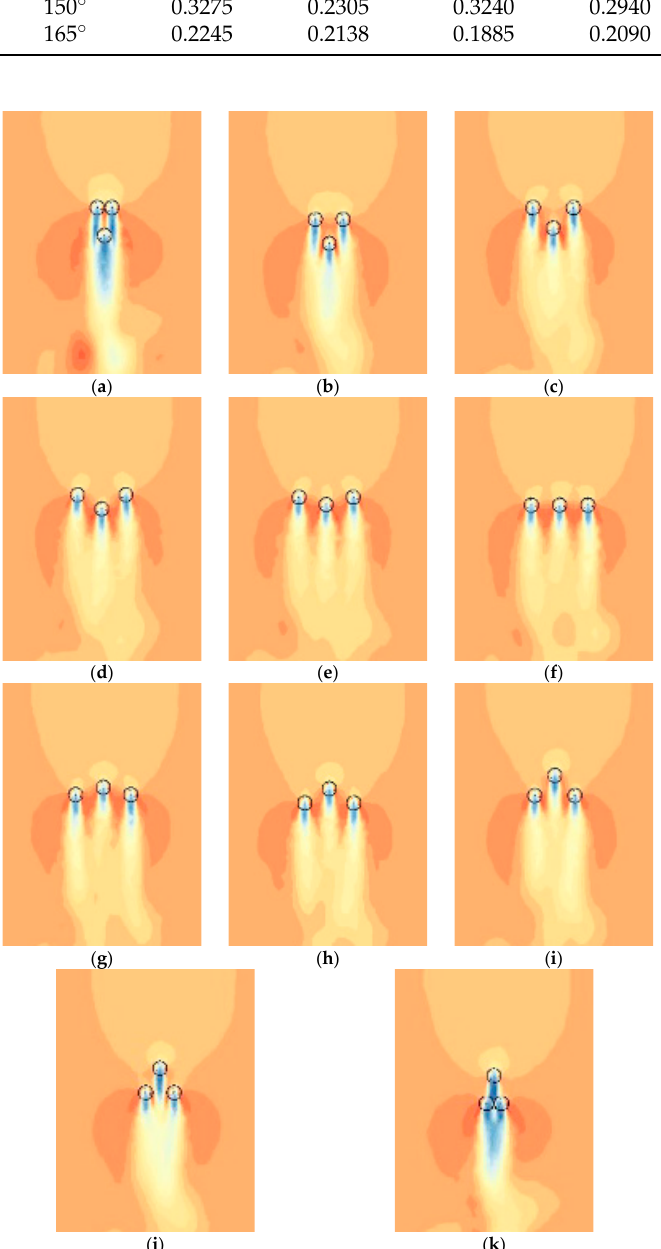
Figure 18. Contour plots of velocity magnitude within the domain for oblique angles of ( a ) 15°, ( b ) 30°, ( c ) 45°, ( d ) 60°, ( e ) 75°, ( f ) 90°, ( g ) 105°, ( h ) 120°, ( i ) 135°, ( j ) 150° and ( k ) 165°.